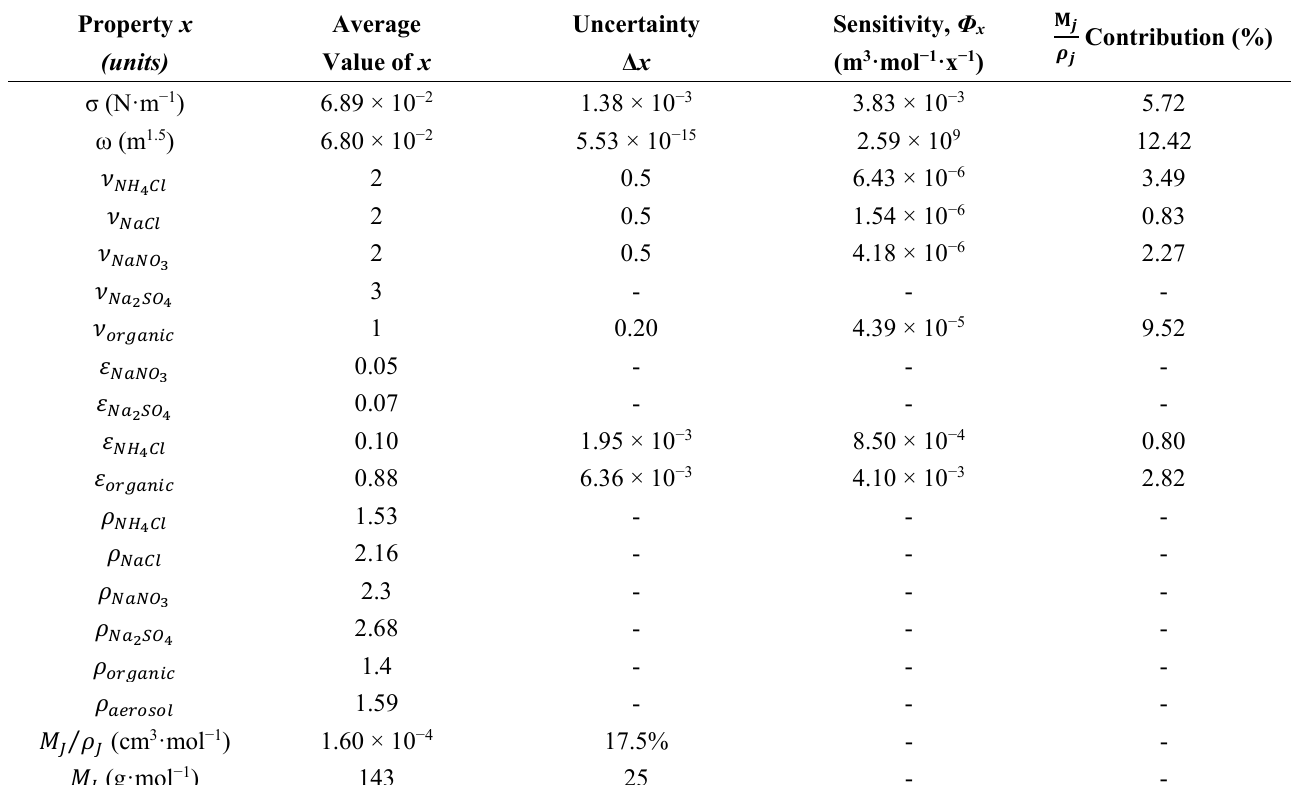
Table 3. Köhler Theory Analysis for Cloud-Residual (CR) samples.